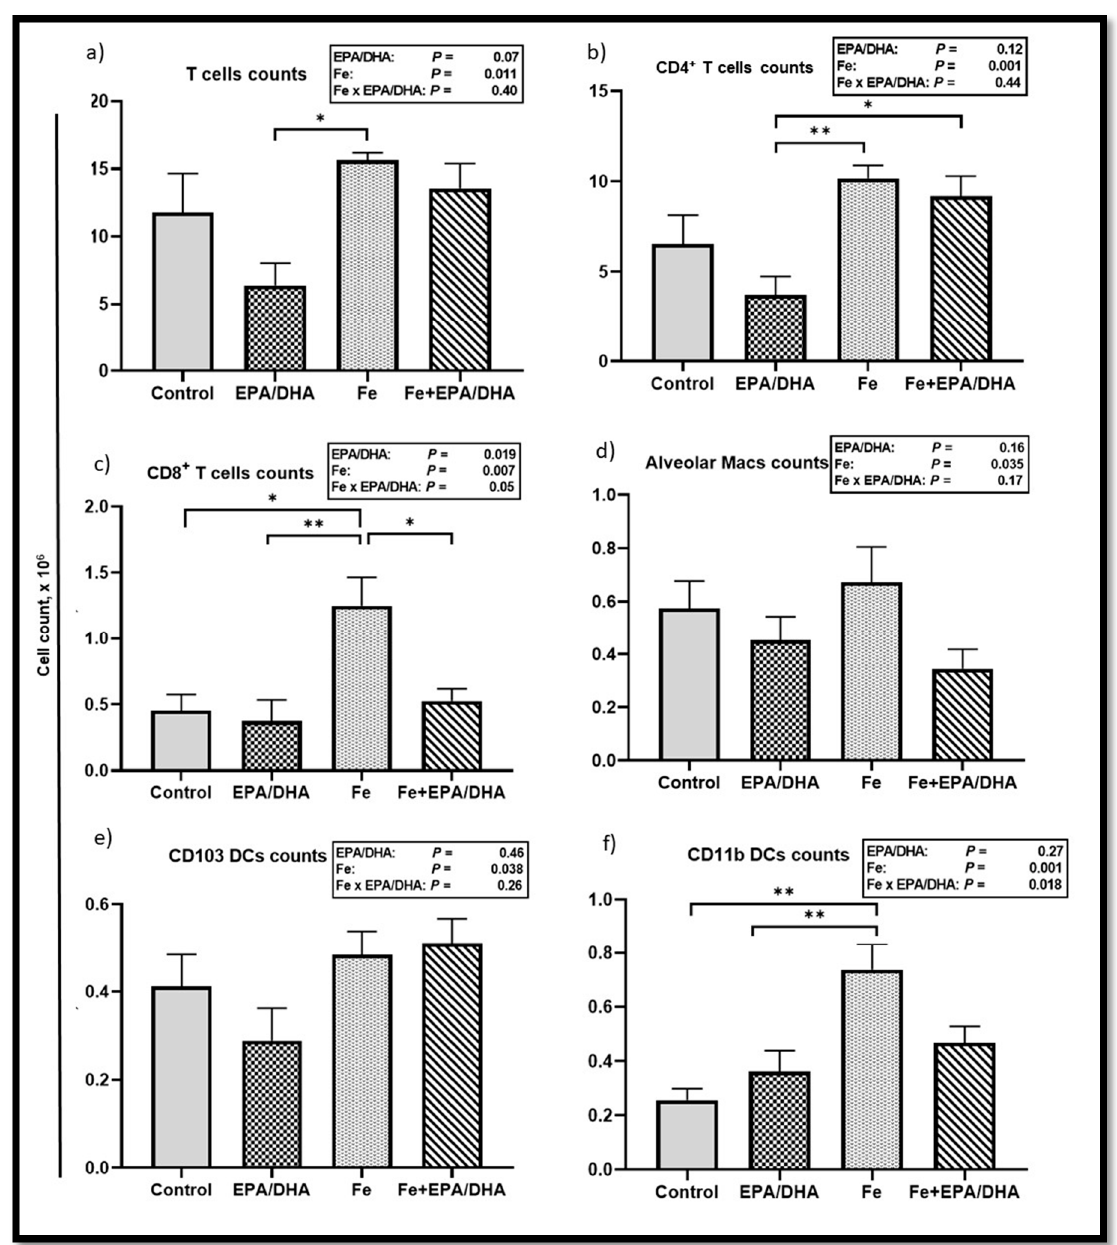
Figure 7. Lung immune cell counts after providing Mtb -infected mice with control, EPA/DHA, Fe, or Fe+EPA/DHA diets for three weeks, including ( a ) T cells, ( b ) CD4 + T cells, ( c ) CD8 + T cells, ( d ) alveolar macrophages, ( e ) CD103 DCs, and ( f ) CD11b DCs. The values represent mean ± SEM. Results